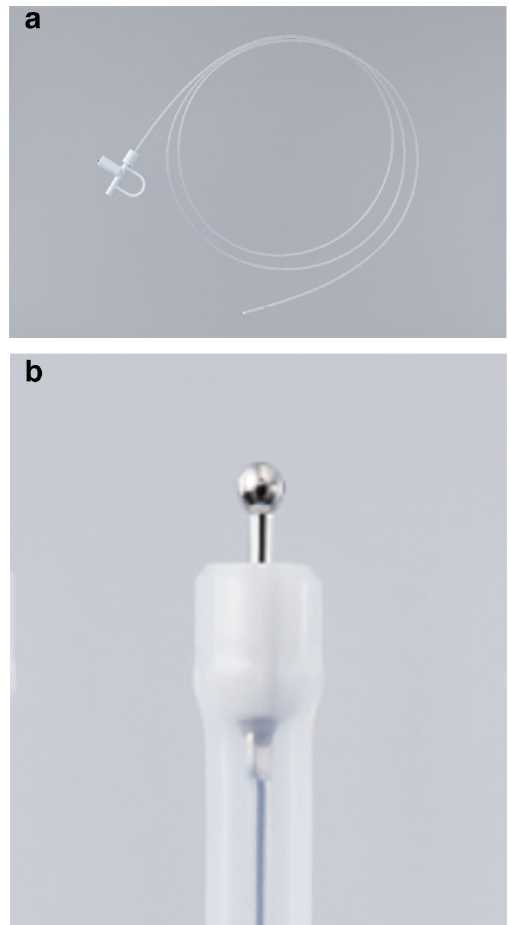
Figure 1. Photographs of the Endosaber (Sumitomo Bakelite, Tokyo, Japan). ( a ) A photo of the entire Endosaber. ( b ) A close-up photograph of the ball-tip on the distal end of the